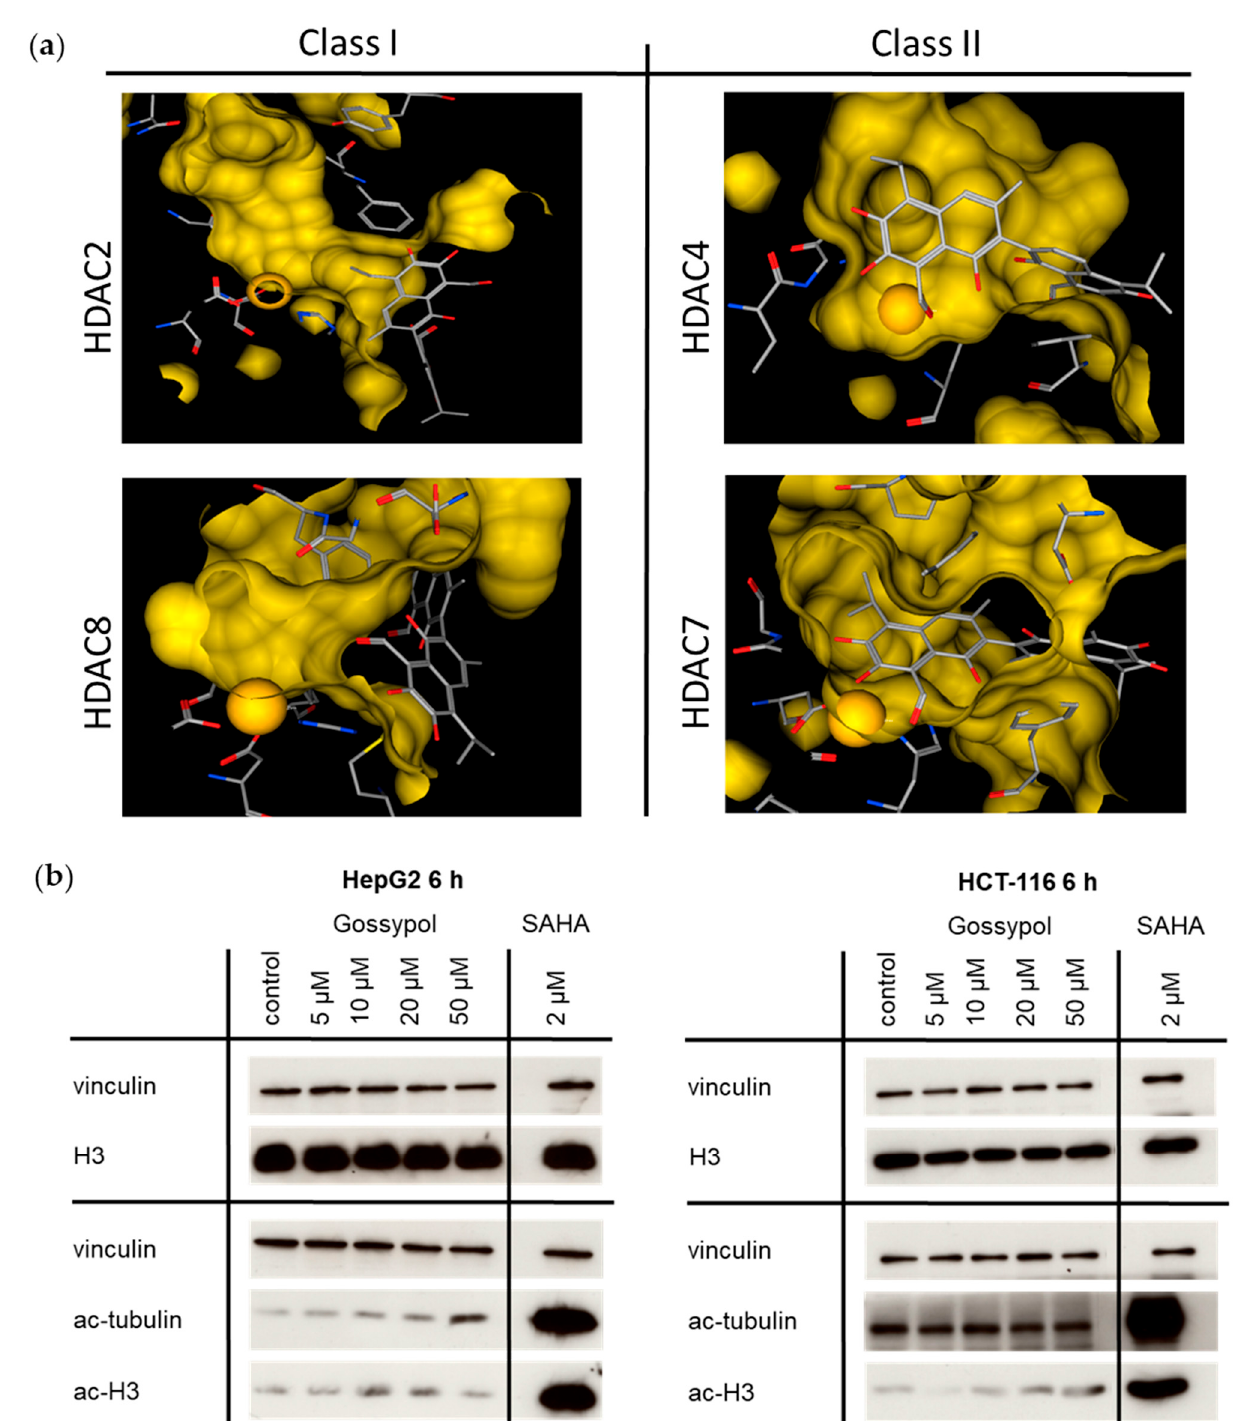
Figure 5. Gossypol inhibits HDAC activity. ( a ) Results of in silico docking analysis of gossypol with crystal structures of HDAC2 and 8 (class I, upper left, lower left) and HDAC4 and 7 (class II, upper right, lower right). The predicted binding modes of gossypol in the binding pocket of different HDACs are shown. The zinc ion (yellow sphere) and other residues of the catalytic center predicted to interact with gossypol are highlighted: carbon, gray; oxygen, red; nitrogen, blue. ( b ) Gossypol-related acetylation status. Western blot analysis of acetylated histone complex H3 (ac-H3) and acetylated tubulin (ac-tubulin) in HepG2 and HCT-116 tumor cells treated with 5 µ M, 10 µ M, 20 µ M, or 50 µ